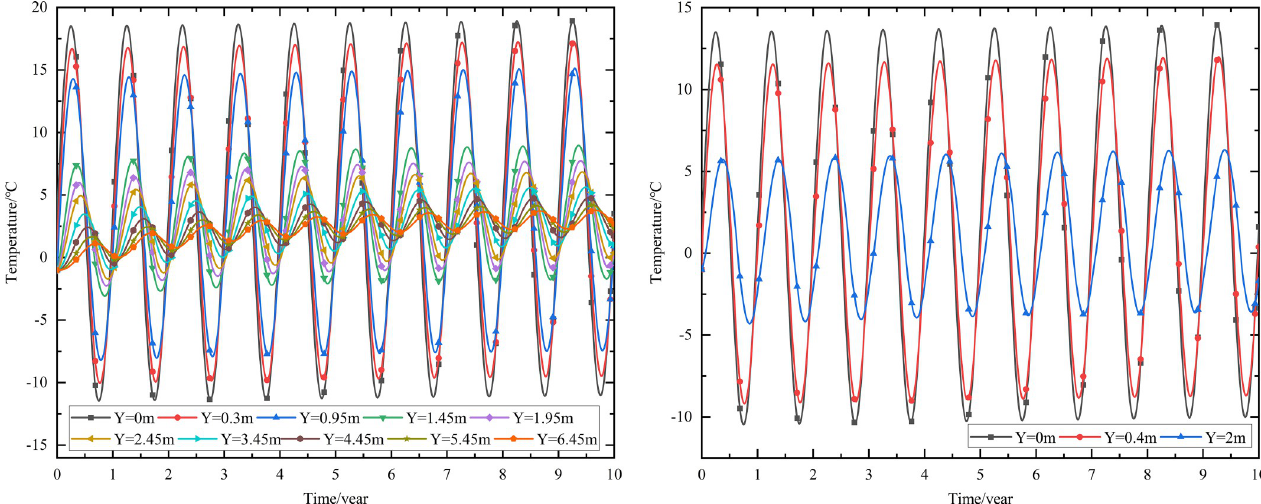
Fig 6. Temperature-time curves at the (a) pavement center and (b) natural surface center.